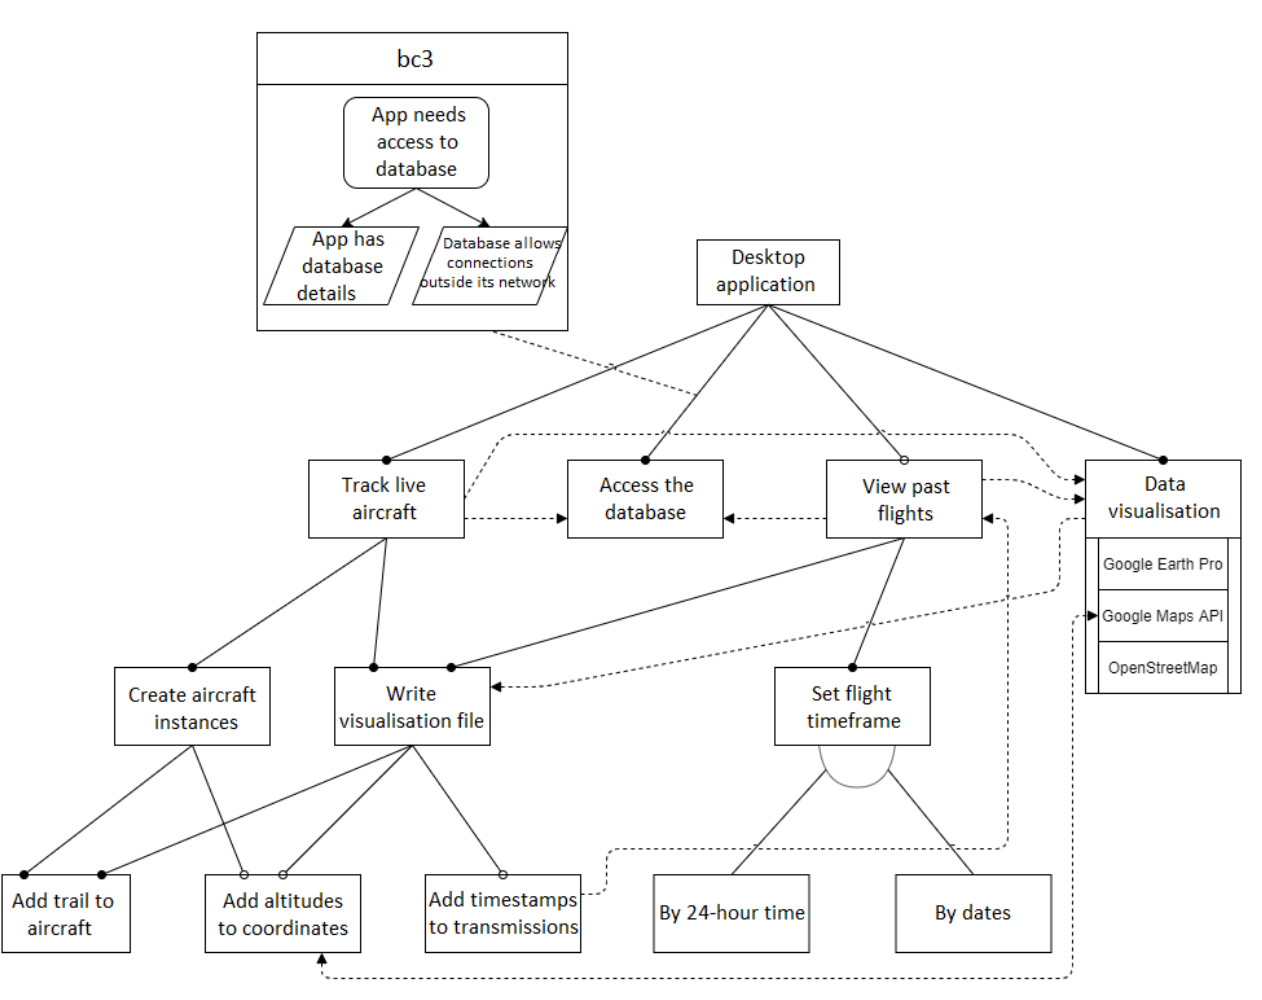
Figure 4. Feature model for the desktop